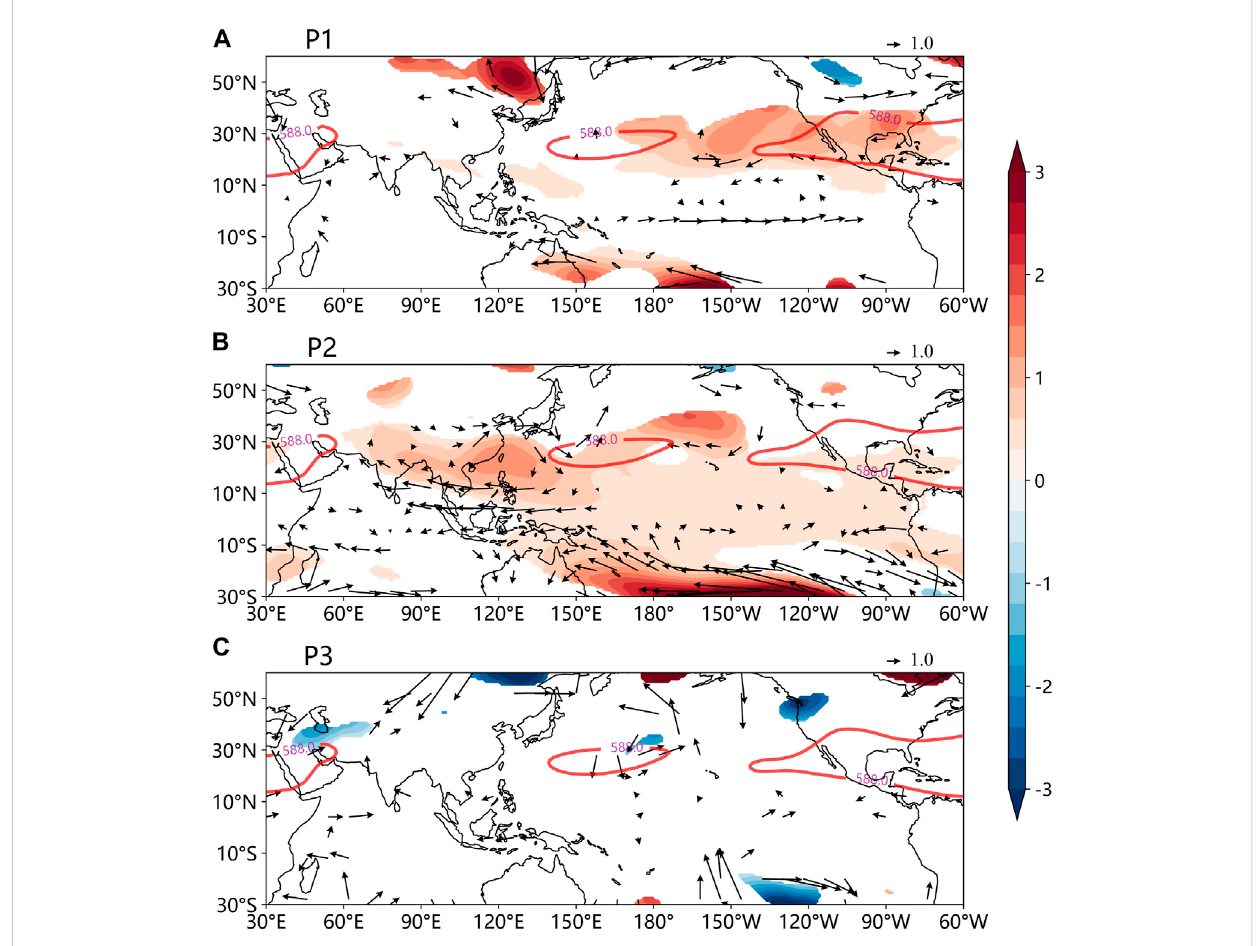
FIGURE 7 Regression coef fi cient of the previous autumn IOD index projected to the 500 hPa potential height anomalies (shadow; Unit: 10gpm) and 500 hPa wind anomalies (vector; Unit: m/s) in the summer during (A) P1, (B) P2 and (C) P3. (The red contours show the 588gpm contours of the multi-year